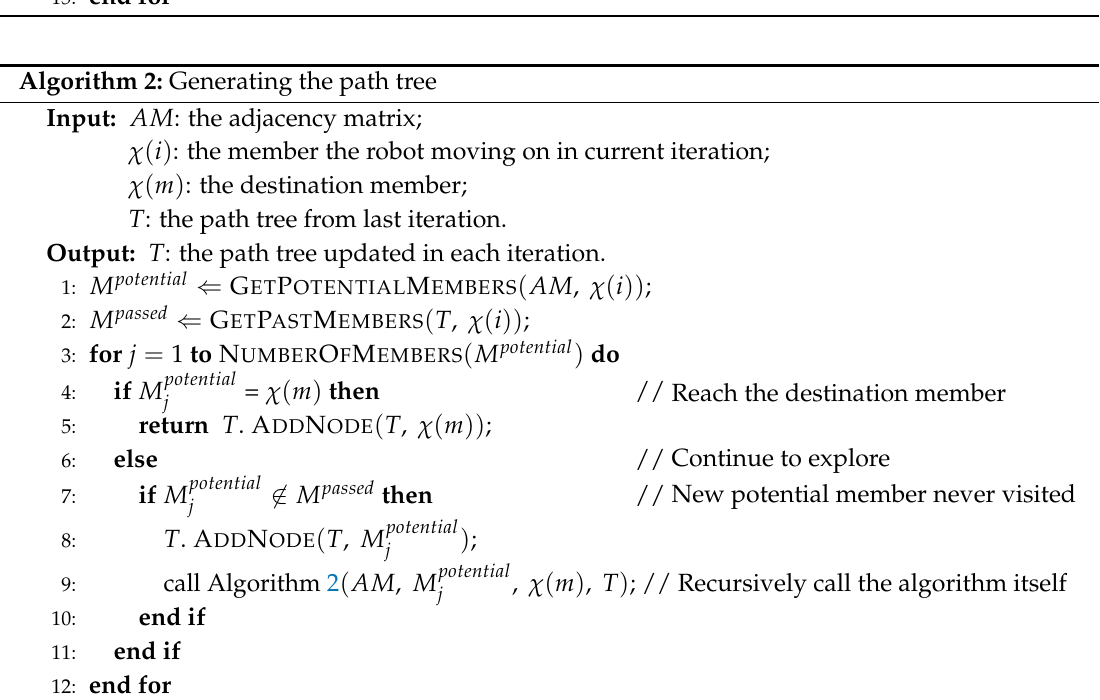
Algorithm 2: Generating the path